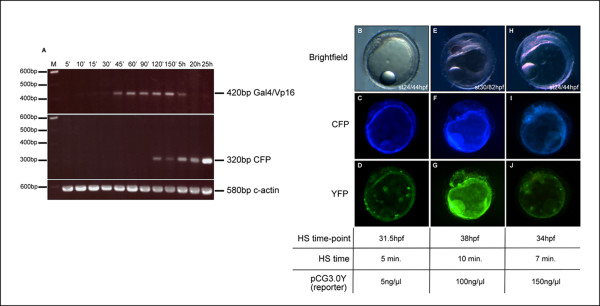
Kinetics of activator and reporter induction (A) and activation of an independent reporter in pCG6.0WCS/T (B-J). A; Transcriptional induction of the activator Gal4/Vp16 and the internal reporter (CFP) in pCG6.0WCS/T was analyzed by RT-PCR. Embryos were heat-shock for 90 seconds at st20/31.5hpf and were allowed to recover for the indicated periods of time. Activator transcripts were detectable already 10 minutes after induction and the levels increased up to 3 hours. Degradation to undetectable levels was complete after 20 hours. Activator dependent transcription of the internal reporter CFP was observed only after 2 hours and levels were still increasing after 25 hours. C-actin was used as an internal control. (B-J); The independent reporter plasmid pCG3.0Y was injected into the transgenic Gal4/Vp16 activator line. Anterior is to the left (B-J). Expressions of both internal and independent reporters were observed in a weak to strong ubiquitous manner (B-J). Occasional higher levels of internal reporter expression were observed in some parts of the embryonic body. These higher levels were paralleled by independent reporter expression (B-D, H-J). Mosaic clones exerting stronger YFP expression reflect locally higher plasmid concentrations (B-J). Abbreviations: h, hours; hpf, hours post fertilization; HS, heat-shock; M, size marker; st, developmental stage.